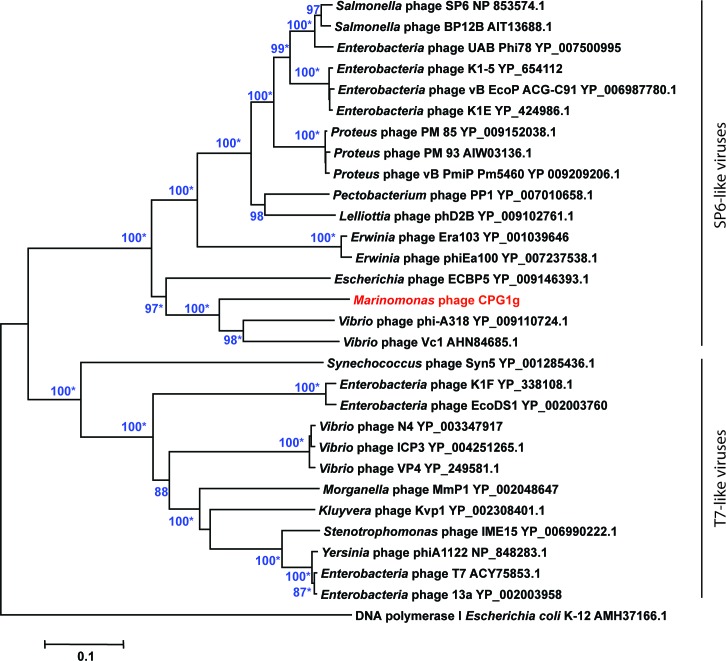
Phylogenetic relationships of phage DNA polymerases.Neighbor-joining tree computed using phage DNA polymerase protein sequences. Numbers at branches indicate bootstrap values >70%. Asterisks indicate that the branches also have bootstrap values >70% in Maximum-Likelihood trees. Escherichia coli DNA polymerase I was used as an outgroup.